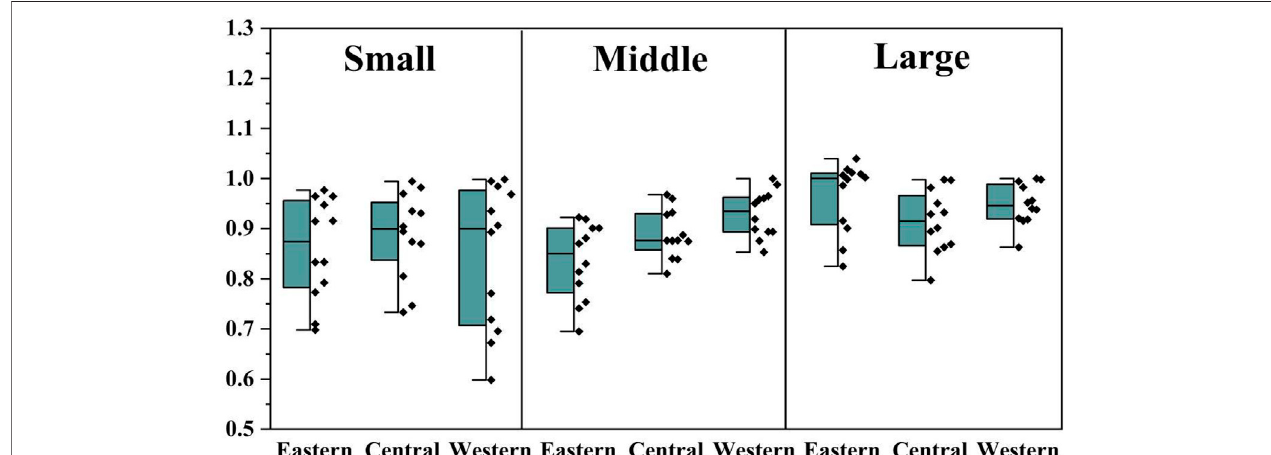
FIGURE 10 | Three scales of TGR in three